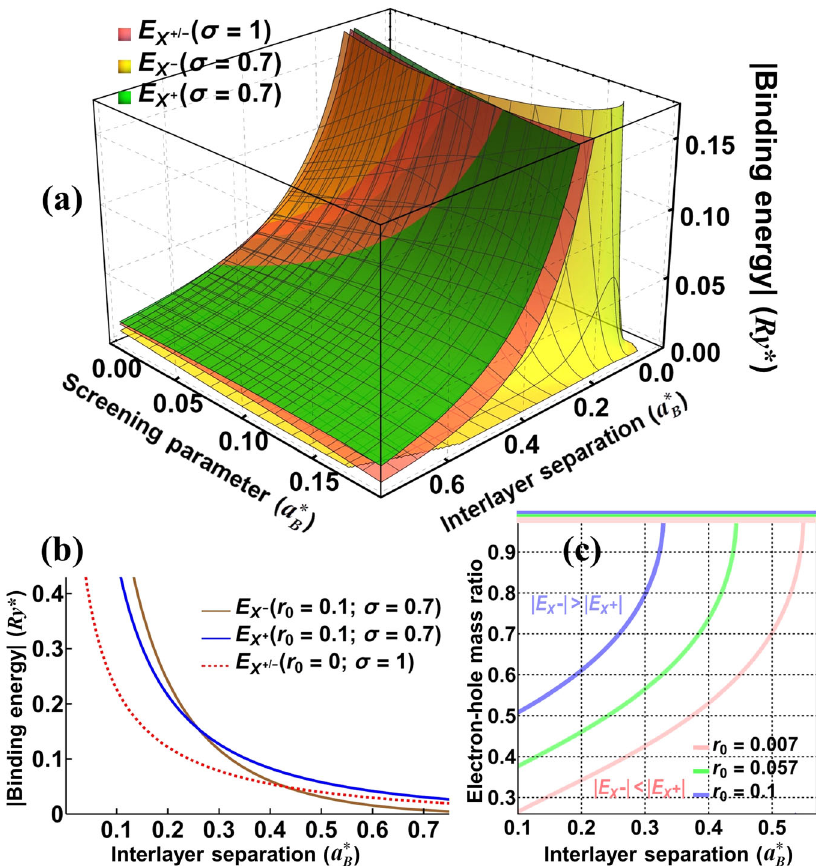
Fig. 2 Charged interlayer exciton binding energy. a Absolute values of the binding energies E X ± of the positive and negative charged interlayer excitons (CIEs) as functions of the interlayer separation d and screening length parameter r 0 as given by Eqs. (1), (2) and (4) for σ = 1 and 0.7 (electron-hole effective mass ratio). b Crosscuts of ( a ) for r 0 = 0 and 0.1 (screening length parameter) to show the binding energy splitting for the positive and negative CIEs with unequal electron-hole masses. c Solutions to the equation j E X þ ð σ ; d Þj ¼ j E X (cid:2) ð σ ; d Þj for the three values of the screening length parameter r 0